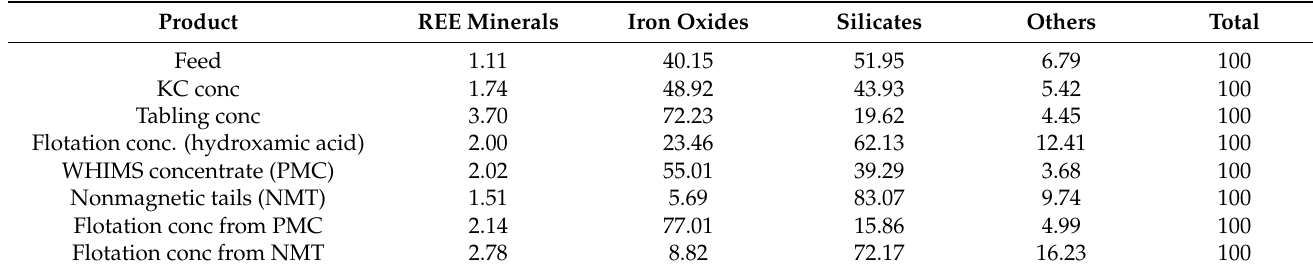
Table 4. Summary of the mineralogical composition of selected separation